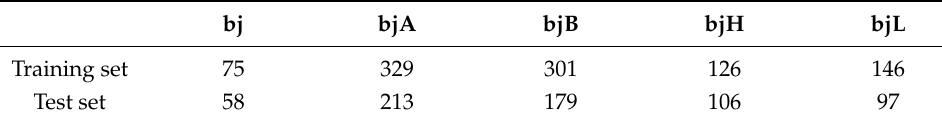
Table 1. Dataset